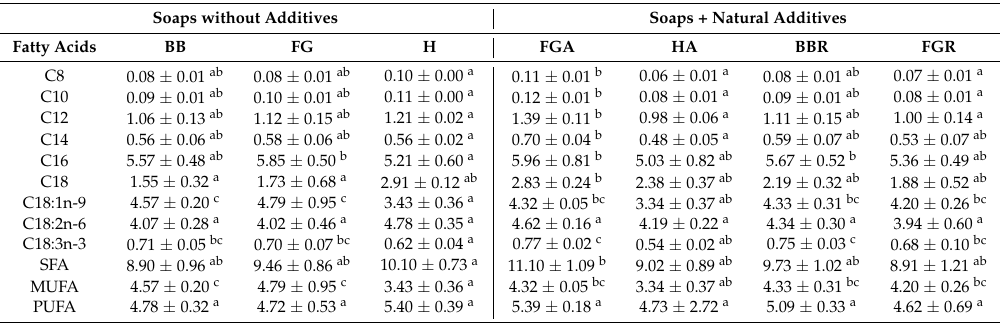
Values (µg/mg) represent means ± standard errors. Means in the same row accompanied by different letters are significantly different between treatments at LSD = 0.05, n = 4 per experimental replicate. SFA = sum of the saturated fatty acids (C8 to C18), MUFA = sum of the monounsaturated fatty acids (C18:1n9), PUFA = sum of the polyunsaturated fatty acids (C18:2n6 + C18:3n3). Natural soap acronyms: BB = base bar (control), FG = forest grove, H = Hibiscus rose hip. FGA = forest grove + essential oil and clay, HA= hibiscus + essential oil and clay, BBR = base bar + rosemary, FGR = Forest grove + rosemary, HR = hibiscus + rosemary.